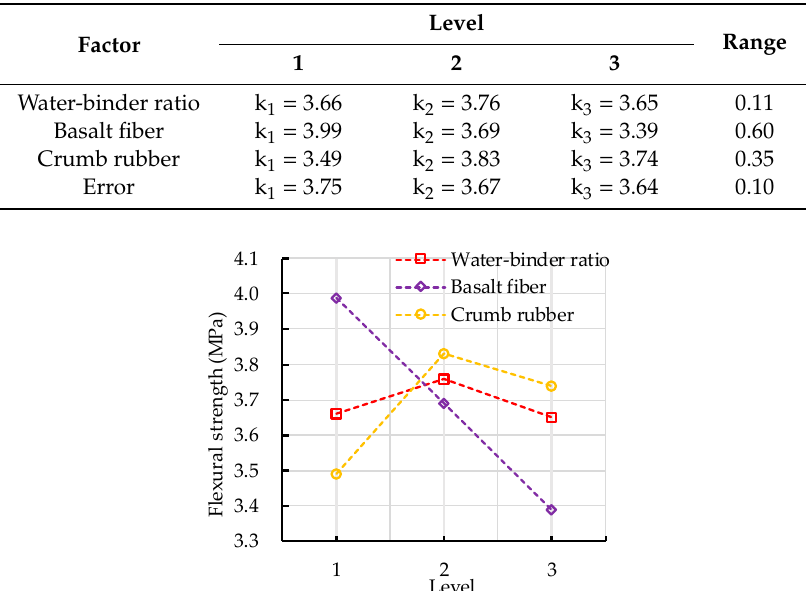
Table 10. Range analysis for flexural strength of CRBFC.